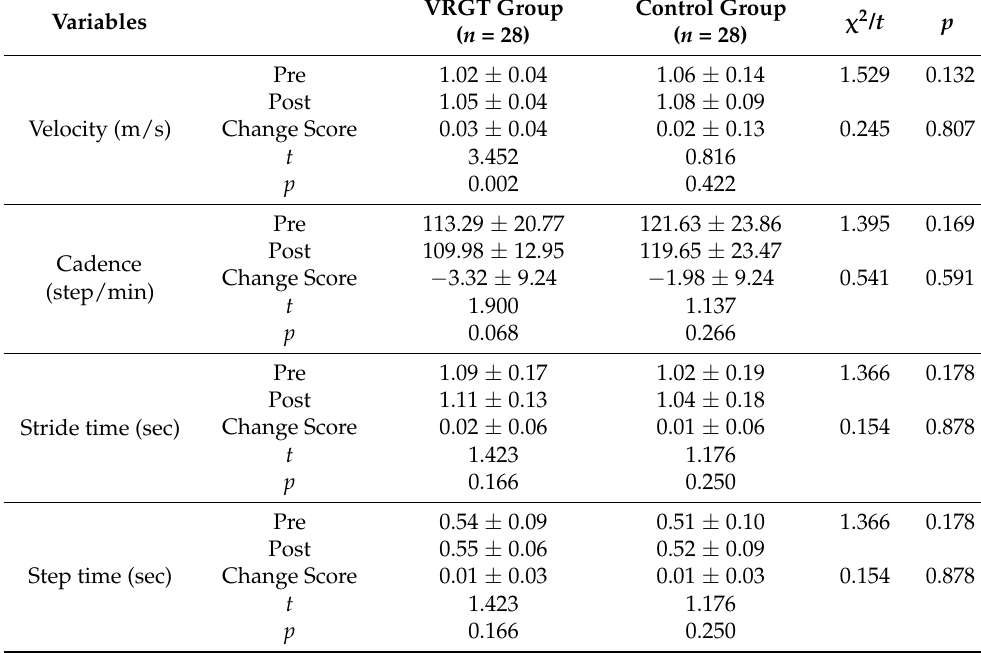
Table 3. Changes of temporal gait parameter.